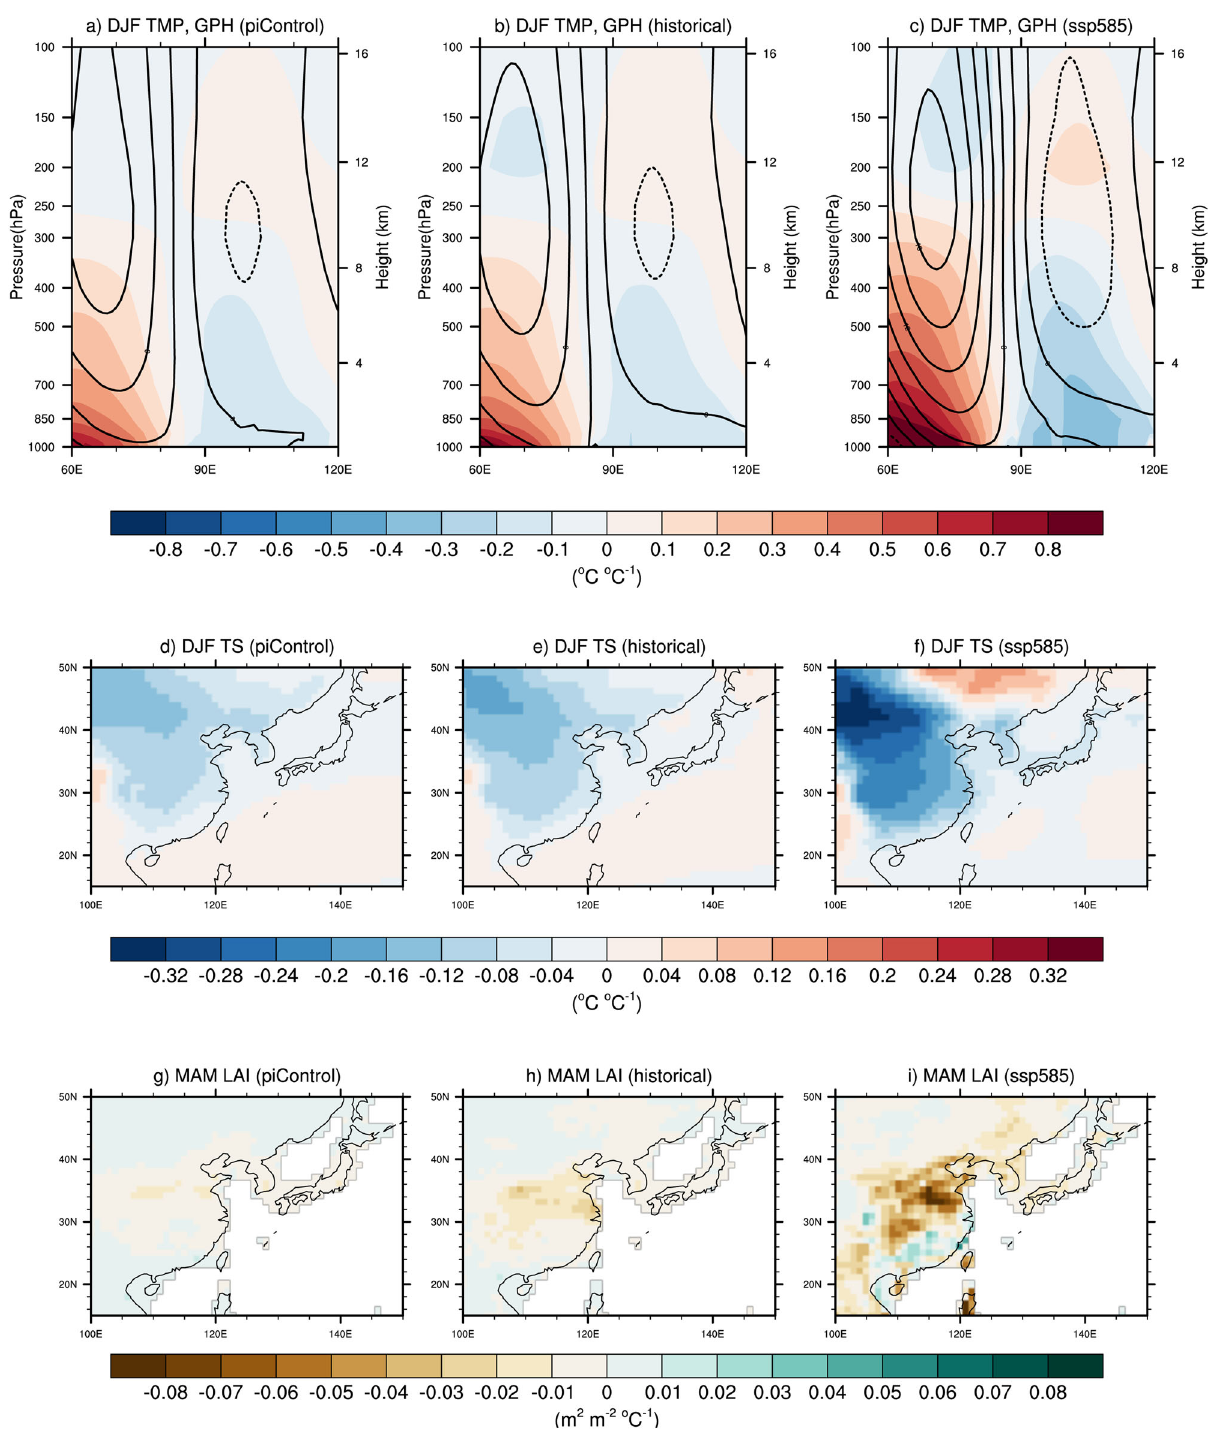
Fig. 4 Intensi fi ed Arctic warming-related teleconnections. a – i The CMIP6 Multi-model ensembles of regression coef fi cients of December – February averaged geopotential height (m °C − 1 ; contour) and temperature (°C °C − 1 , shaded) ( a – c ), December – February averaged temperature (°C °C − 1 ) ( d – f ), and March – May averaged leaf area index anomaly (m 2 m − 2 °C − 1 ) ( g – i ) onto December – February ART index under pre-industrial ( a , d , g ), historical ( b , e , h ), and ssp585 ( c , f , i ) Linear regression analysis . Linear regression is conducted to estimate the ART- LAI regression fi elds 49,50 . The number of grids at the 95% con fi dence level rank induced teleconnection and terrestrial impacts onto the de-trended ART index. In 960th and 984th highest values among 1000, therefore the hypothesis is that the order to focus on interannual relation, linear trends from all datasets were fi rstly regression patterns in Fig. 2c,d are a chance occurrence that can be rejected at the removed and the linear trend of ART index is accordingly removed based on the 95% con fi dence level. As shown in Supplementary Fig. 5 and described in Sup- same data period of the target data. The signi fi cance test conducted in this study is plementary Note 1, we also use a multiple regression to investigate the individual based on a standard two-tailed Student ’ s t -test. We also employed a fi eld sig- contributions of the temperature and precipitation anomalies to leaf area ni fi cance test based on 1000 Monte Carlo simulations to evaluate the signi fi cance of index 51,52 . Consequently, the partial regression coef fi cients approximately